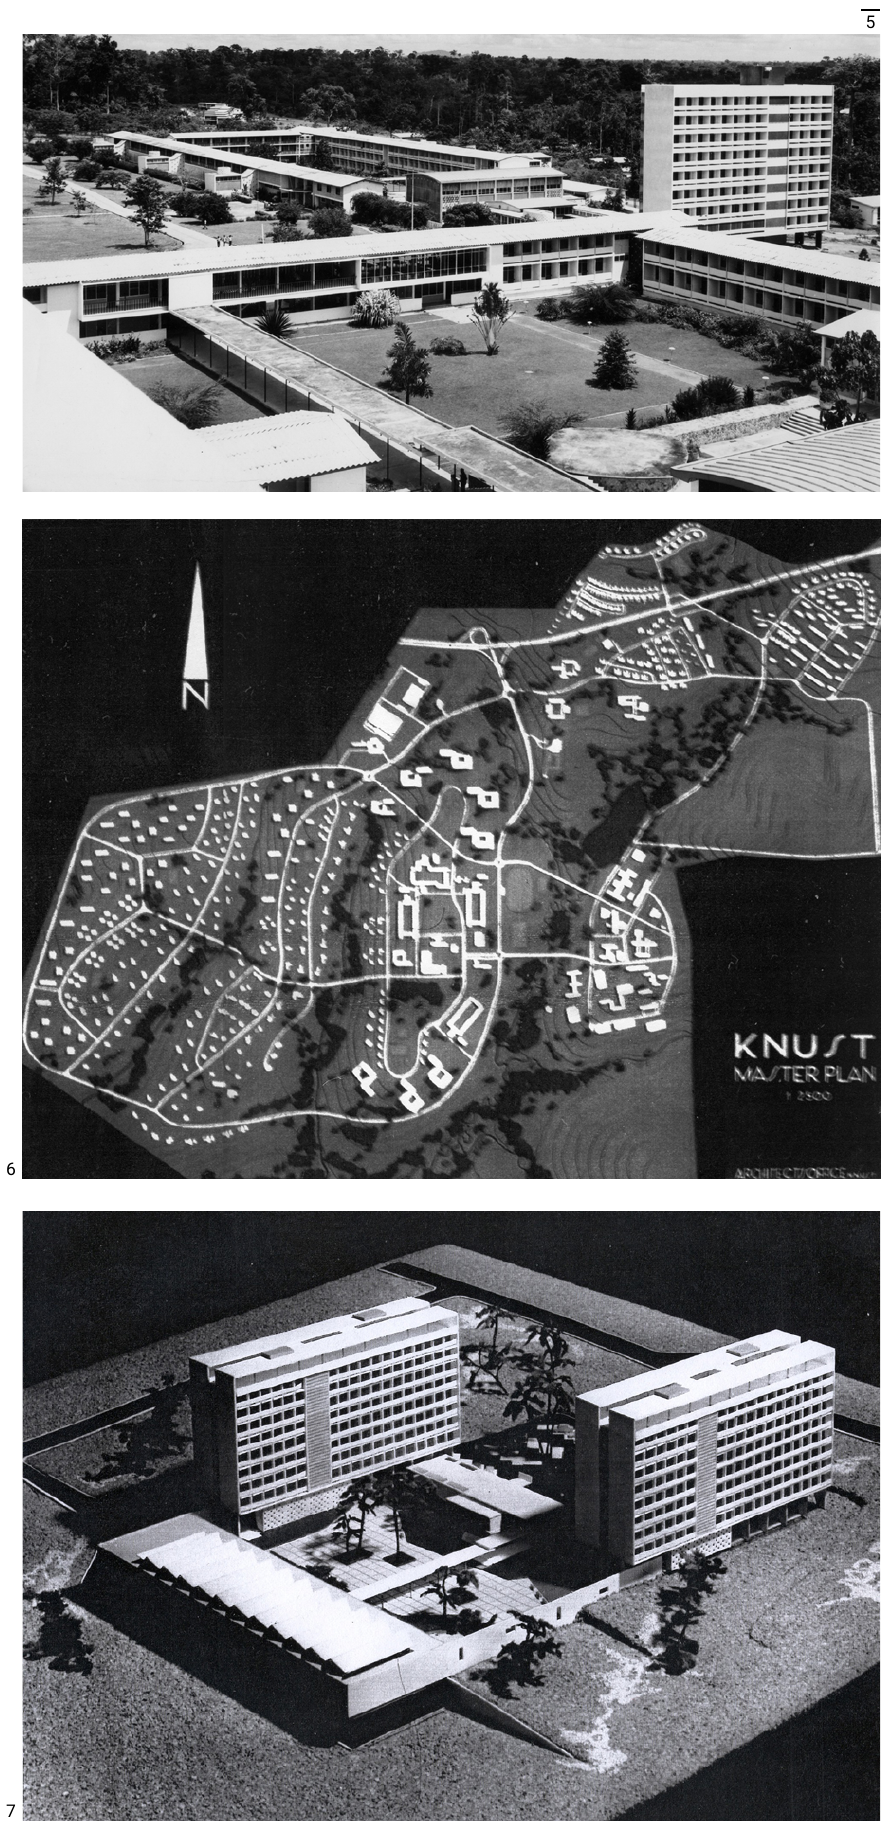
Miro Marasović and John Owusu Addo, Unity Hall –